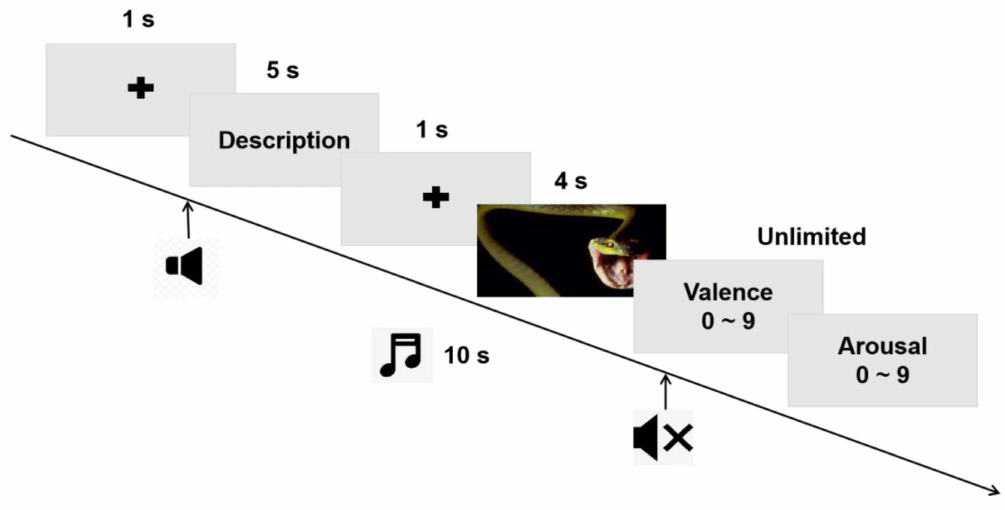
Figure 1. Experimental paradigm of cognitive reappraisal in combination with happy